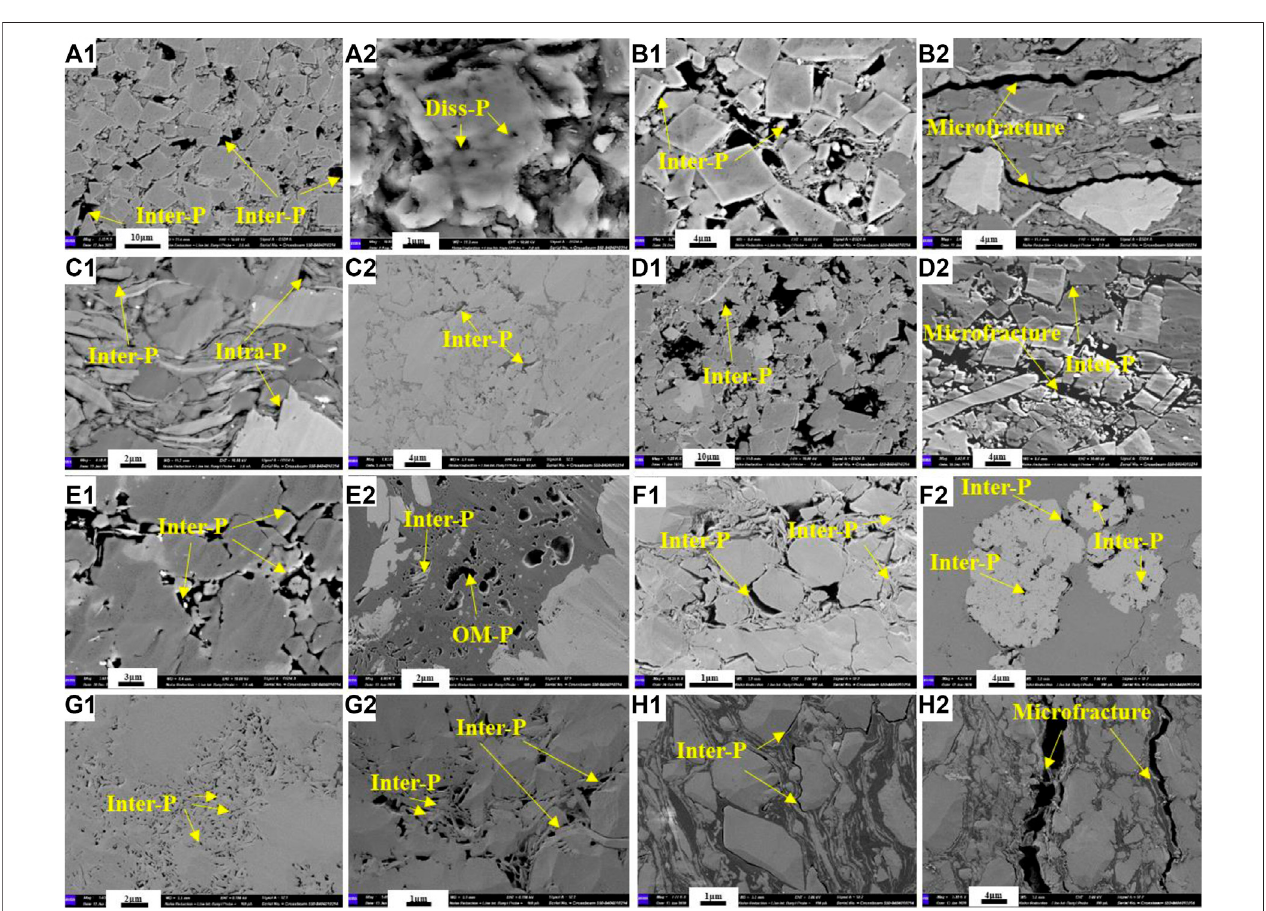
FIGURE 12 | SEM images of shale samples show reservoir porosity types in different lithofacies. Borehole locations are available in Figure 1B . A1) Interparticle poresofC-1shalesamplefromG-Xwell,2952.04 m.A2)DissolutionporesofC-1shalesamplefromGD-Ywell,4142.31 m.B1)InterparticleporesofC-2shalesample from G-X well, 3176.75 m. B2) Microfractures of C-2 shale sample from G-X well, 3176.75 m. C1) Interparticle pores of C-3 shale sample from GD-Y well, 4115.55 m. C2) Interparticle pores of C-3 shale sample from G-Z well, 3840.71 m. D1) Interparticle pores of S-1 shale sample from GD-X well, 2952.04 m. D2) Interparticle pores and microfractures of S-1 shale sample from G-Z well, 3858.2 m. E1) Interparticle pores of S-2 shale sample from GD-Y well, 4111.44 m. E2) Organic and interparticleporesofS-2shalesamplefromGD-Ywell, 4134.52 m.F1)InterparticleporesofS-3shale samplefromGD-X well,3315.75 m.F2)Interparticle poresofS-3 shale sample from GD-Y well, 4117.37 m. G1) Interparticle pores of M-1 shale sample from G-X well, 3057.7 m. G2) Interparticle pores of M-1 shale sample from GD-Z well, 3866.47 m. H1) Interparticle pores of M-2 shale sample from G-X well, 3176.75 m. H2) Microfractures of M-2 shale sample from G-X well, 3176.75 m.